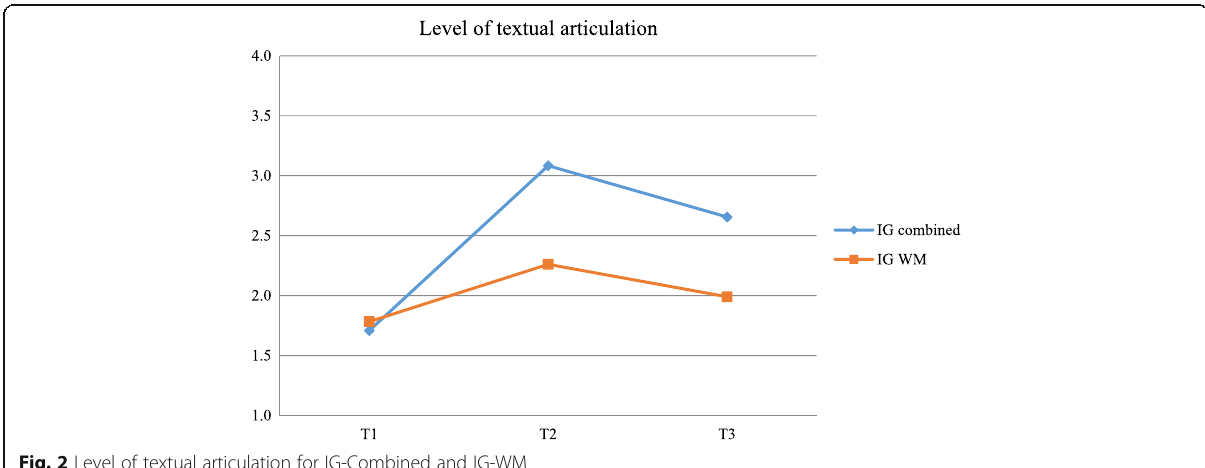
Fig. 2 Level of textual articulation for IG-Combined and IG-WM